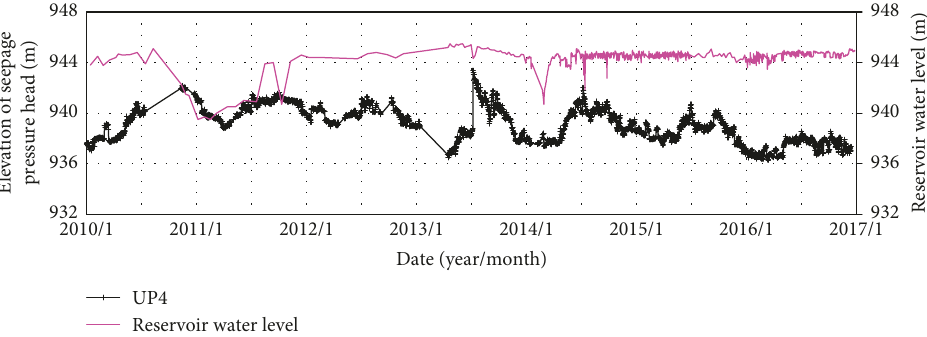
Figure 8: Time series for seepage pressure head at UP4 and reservoir water level.